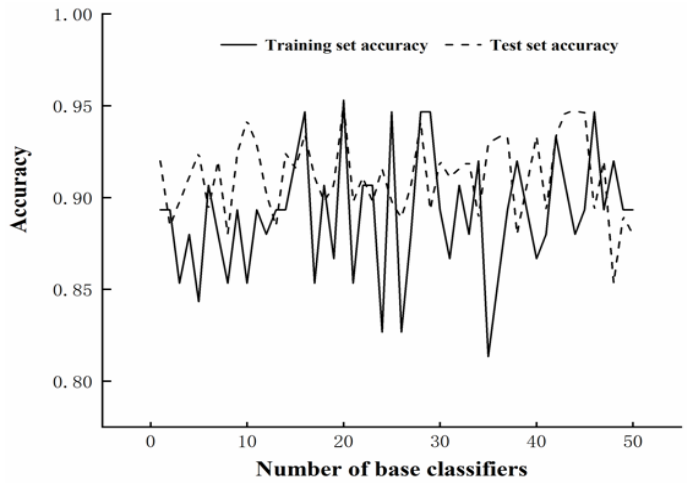
Figure 7. The variation curve of the coal gangue image recognition accuracy of AdaB-GA-SVM with a different number of integrated base classifiers.